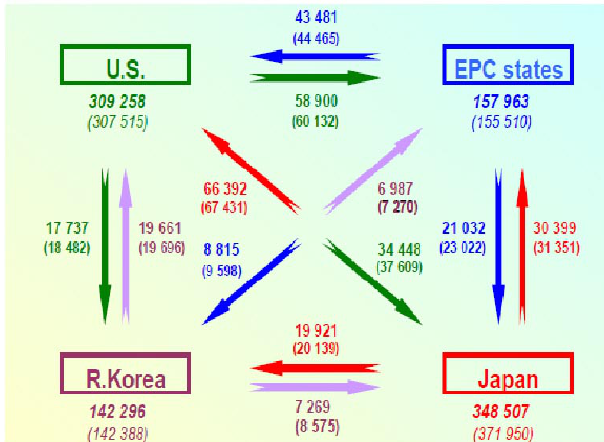
Fig. 2. Single priority patent families arising from first filings in 2006 (2005 in brackets), indicating first filings and flows, which are the counts of first filings referenced as priorities in subsequent filings in other blocs. From